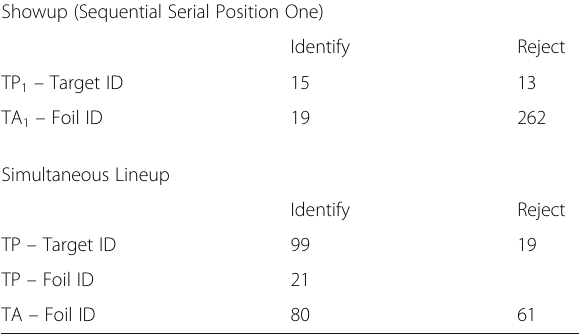
Table 7 Decision outcomes frequencies for sequential serial position one, treated as a showup, and the simultaneous lineup Showup (Sequential Serial Position One) Identify